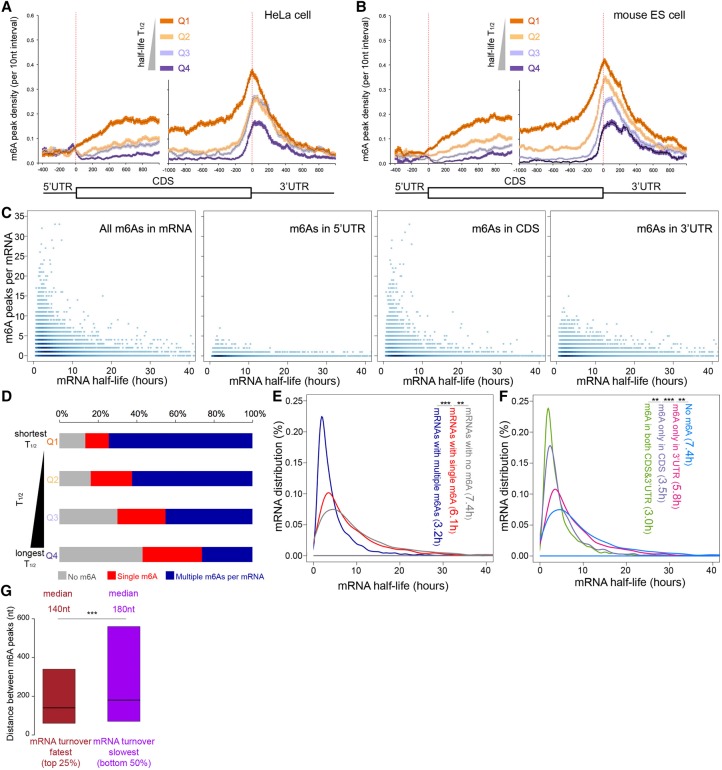
mRNAs with short T1/2s are enriched for multiple m6As. (A) mRNAs with shorter T1/2s have higher m6A density in HeLa cells. Tani et al. (2012) and our data on m6A location within the mRNAs were used to determine any correlation between T1/2 and m6A content. (B) mRNAs with shorter T1/2s have higher m6A density in mouse ESCs. (C) The scatter density plot of m6A peak numbers for mRNA T1/2s for individual mRNAs (dots). (D) Proportion of mRNAs with no, one, or multiple m6As in four quartiles of mRNAs with different T1/2s (a range of 0.6–40 h). (E) The amount of mRNA versus mRNA T1/2, grouped by m6A numbers per mRNA. The T1/2 distribution of mRNAs is plotted as a function of m6A content. (**) P < 10−9; (***) P < 10−100, Wilcox ranked test. (F) The effect of position of m6A on T1/2 within mRNA. (**) P < 10−6; (***) P < 10−38, Wilcox ranked test. There is little correlation between internal exon m6A (mostly CDS) and last exon m6A (mostly 3′ UTR). (G) m6A peaks on mRNAs with short T1/2s that tend to be more closely spaced on mRNAs with short T1/2s are labeled in brown; mRNAs with long T1/2s are labeled in purple. (***) P < 10−20, Wilcox ranked test. We observed the same result even when matching the m6A numbers in both groups of mRNAs.